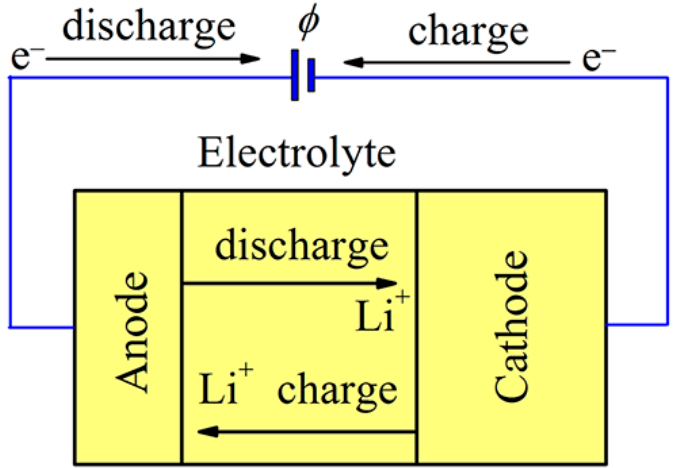
Figure 1. Schematic picture of a rechargeable electrochemical Li cell. When the battery charges, Li is intercalated into the anode; upon discharging, the Li ions are removed from the anode. Let x = N Li / N Si denote the ratio of the number of Li atoms to the number of Si atoms in of Li x Si in the range of x 1 ≤ x ≤ x 2 can be represented using the